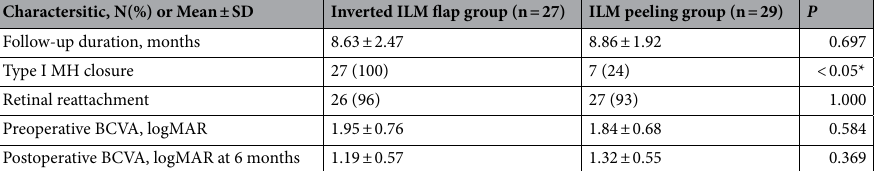
Charactersitic, N(%) or Mean ±